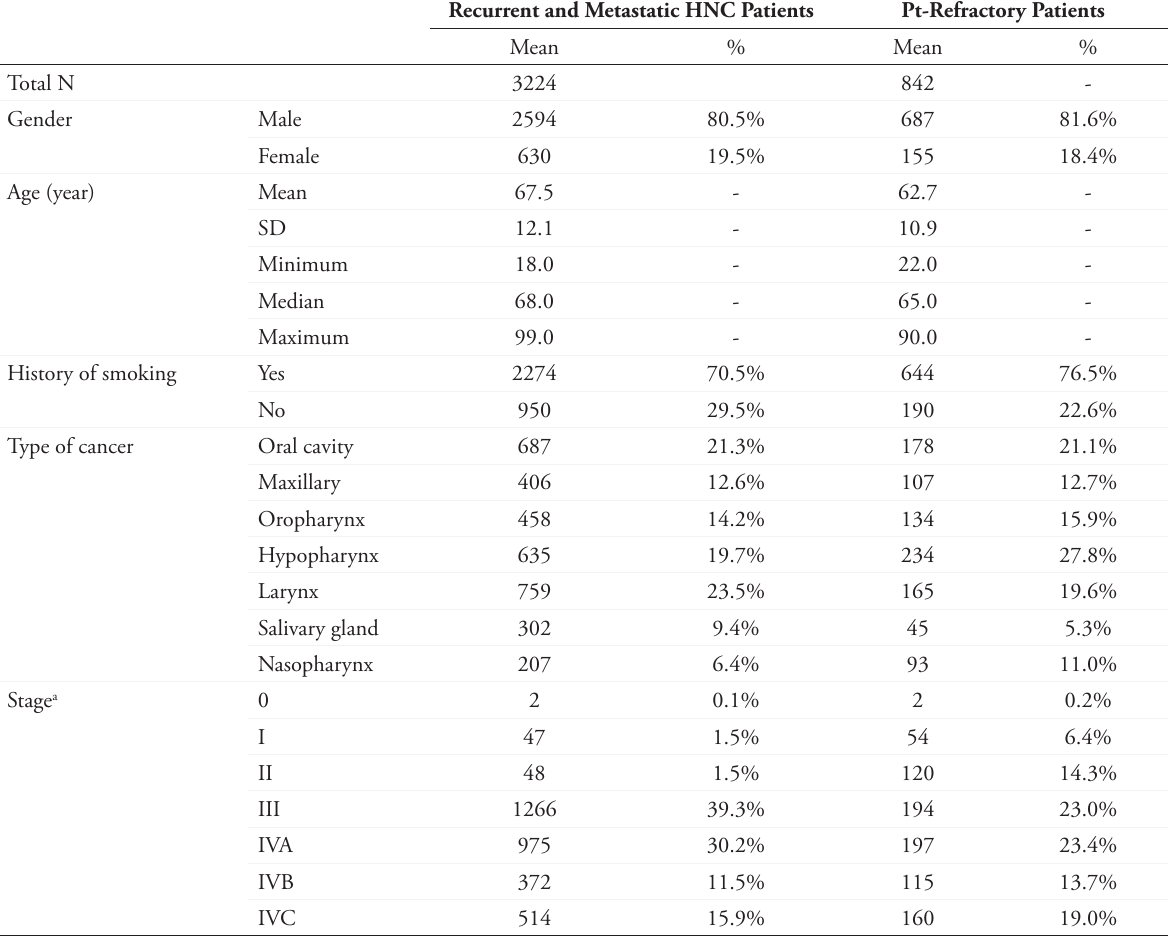
Table 1. Characteristics of Recurrent and Metastatic HNC Patients and Platinum-Refractory